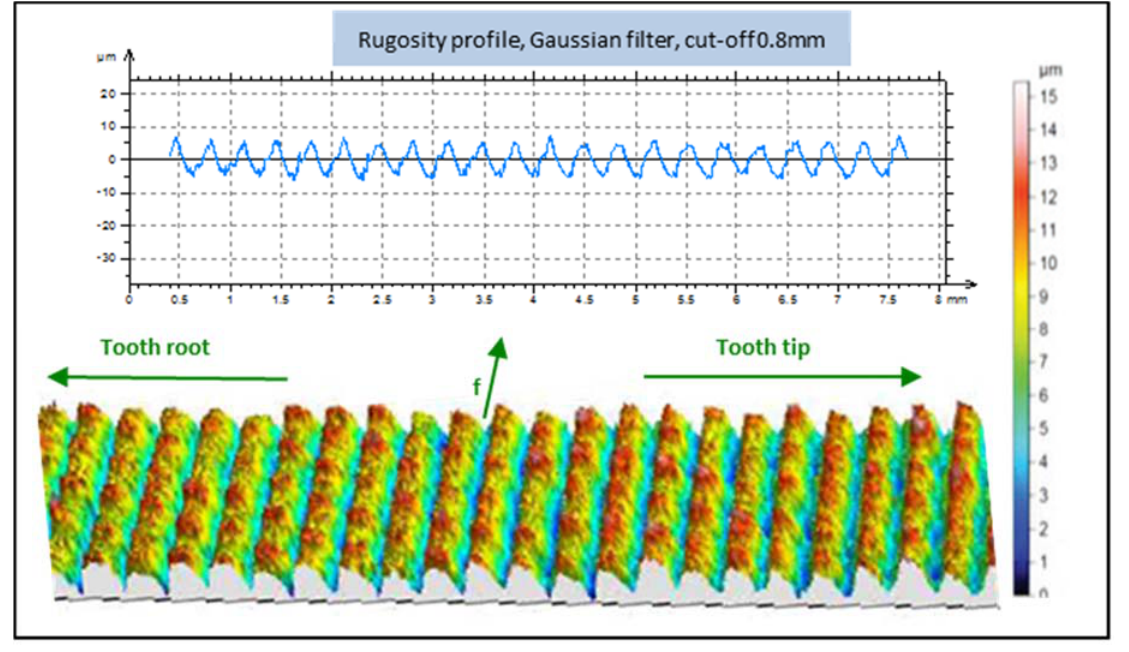
Figure 14. Surface analysis results. Table 6. Roughness values ( μ m).